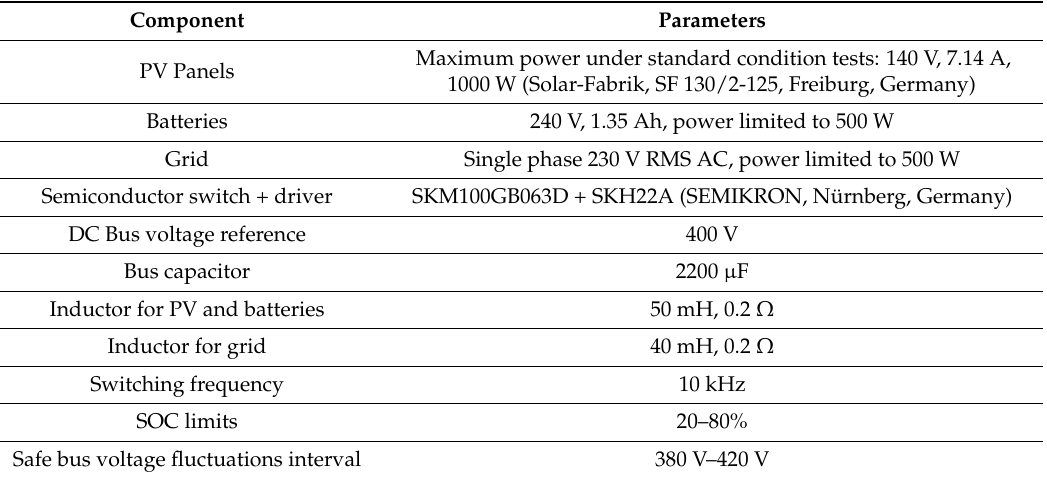
Table 1. Simulation system